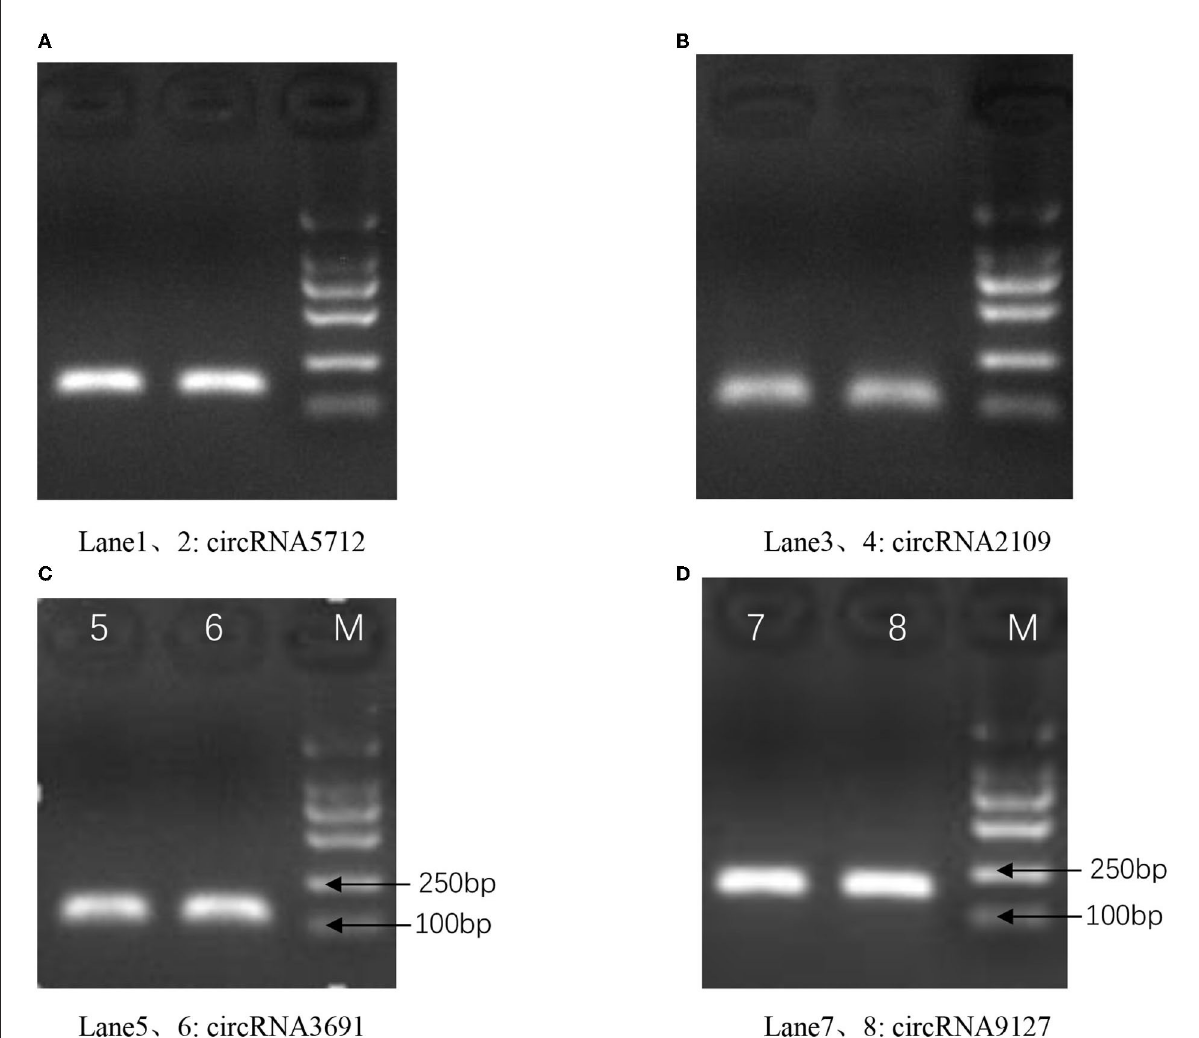
FIGURE8 The existence of circRNA was confirmed by PCR and agarose gel electrophoresis assay. Panels (A–D) represent the amplified bands of circRNA5712, circRNA2109, circRNA9127, and circRNA3691 on agarose gel electrophoresis,